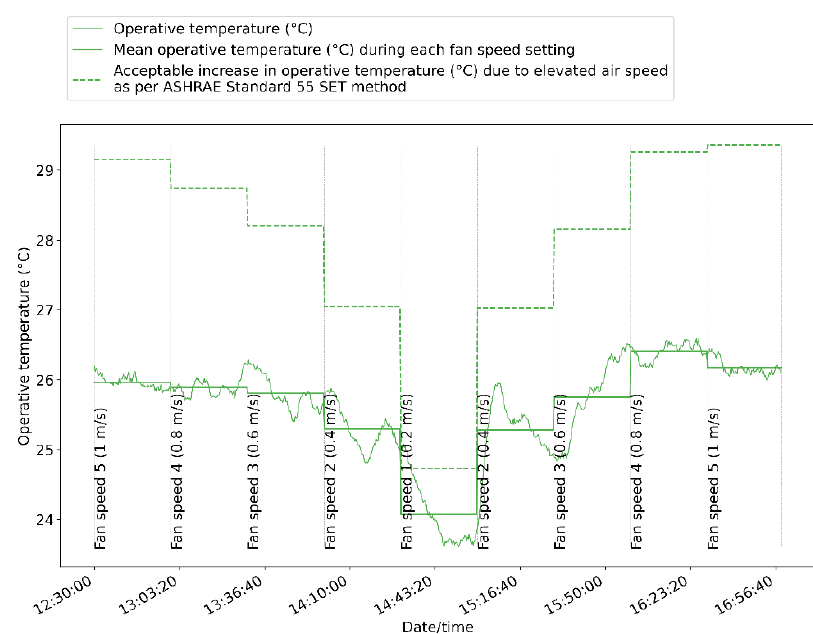
Figure 10. Indoor operative temperature and fan speeds during the experiment.